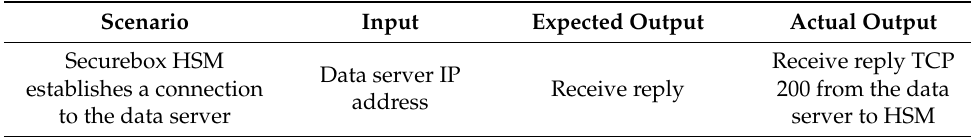
Table 7. Securebox HSM establishes connection testing.